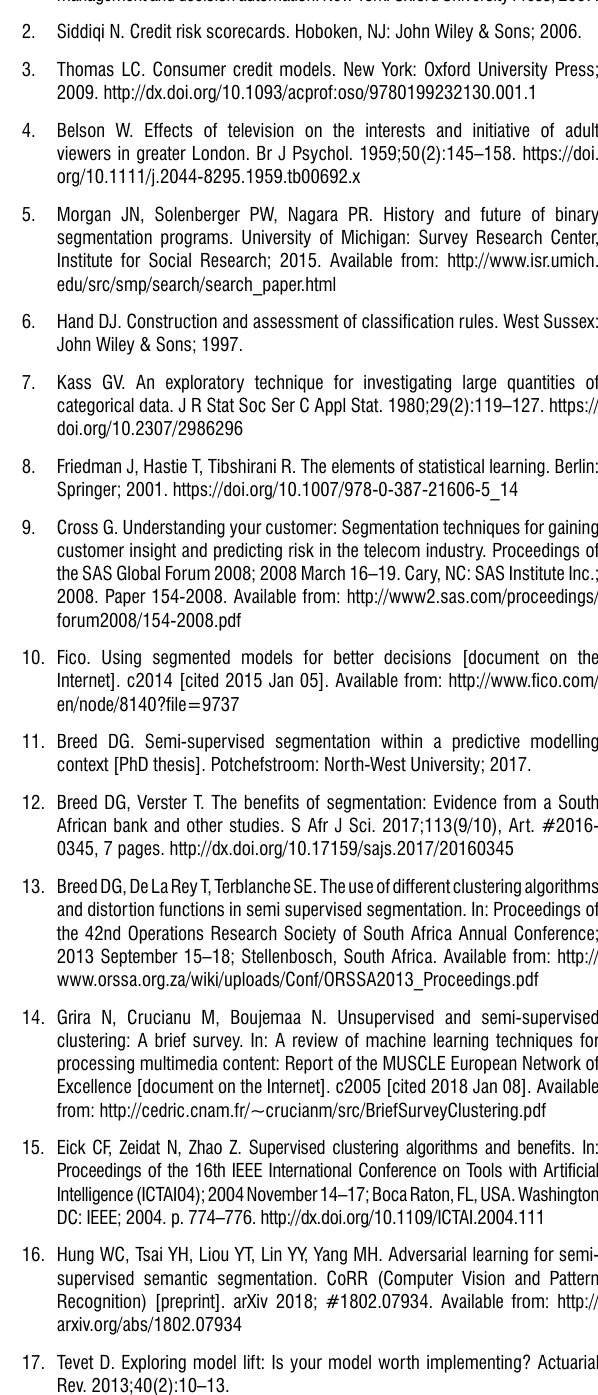
Table 8: Median and average rank of the semi-supervised segmentation (with logistic regression) techniques across all data sets Modelling technique Median rank Average rank SSSKMIV 2 1.67 SSSKMCSQ 3 2.83 SSSWong 5 5.00 SSSKMIV 3 2.83 SSE LK-Means 3